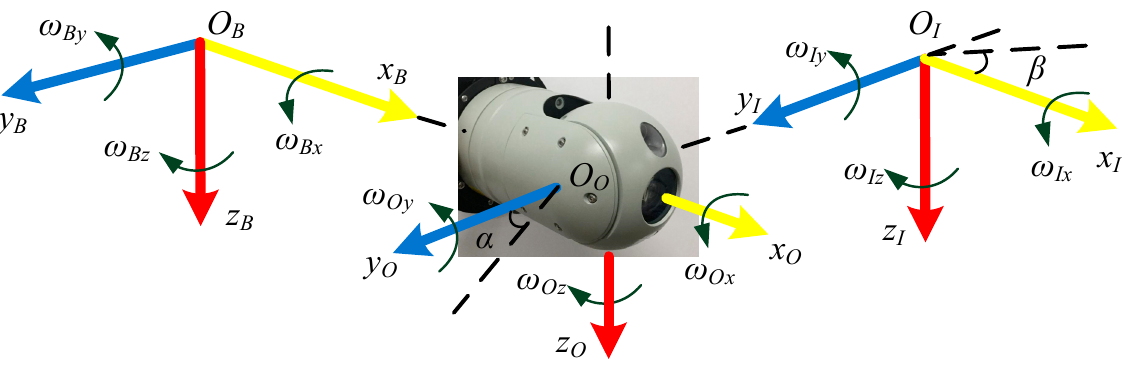
Figure 1. The coordinates of the camera stabilized platform. The platform is installed on a rack, as shown in Figure 2. The roll and pitch gimbals are driven by the actuators with angles α and β , which can counteract the motions from the base. The variables σ and μ represent the angles of LOS in roll and pitch rotations. The angular velocities of the LOS and the actuators are represented by triads of vectors ω m = ( α ’ , β ’ , 0) T , and ω L = ( σ ’ , μ ’ , 0) T . The relationship of the angular velocities between the LOS and the actuators can be represented by Equation ω L = R IB · ω B + ω m , where the transition matrix is expressed by (4).